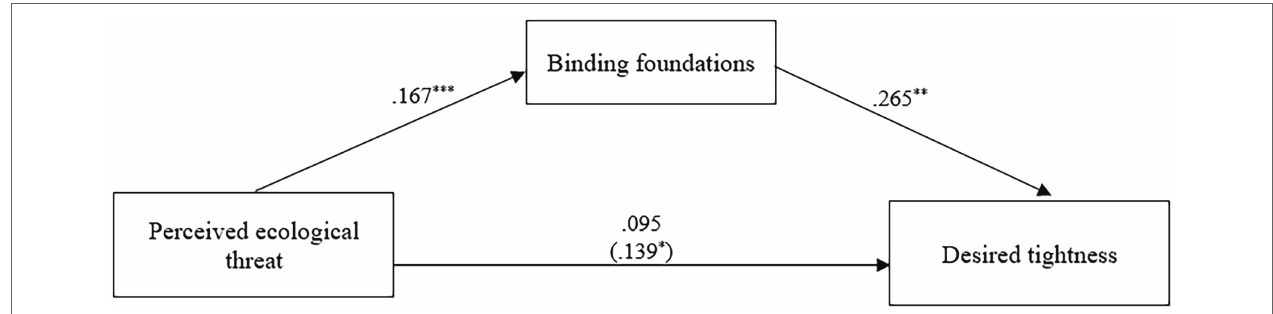
FIGURE 2 | Mediation model. Unstandardized coefficients representing effects of perceived ecological threat on the binding moral foundations and desired tightness. The total effect is in parentheses. To simplify the presentation, the control variables have been omitted. * p < 0.05, ** p < 0.01, *** p <